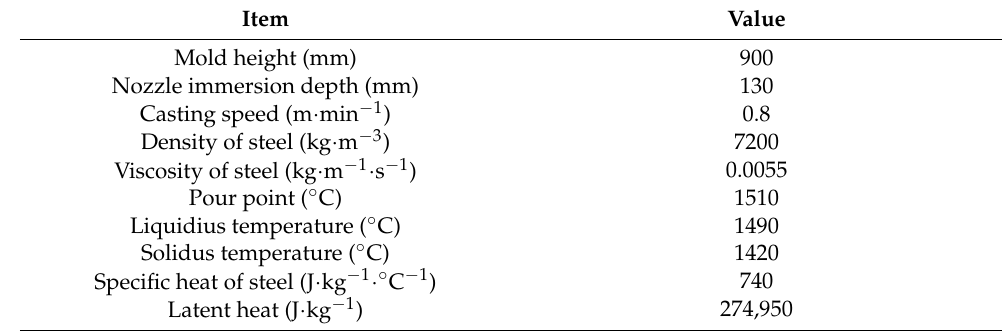
Table 1. Operational parameters and steel